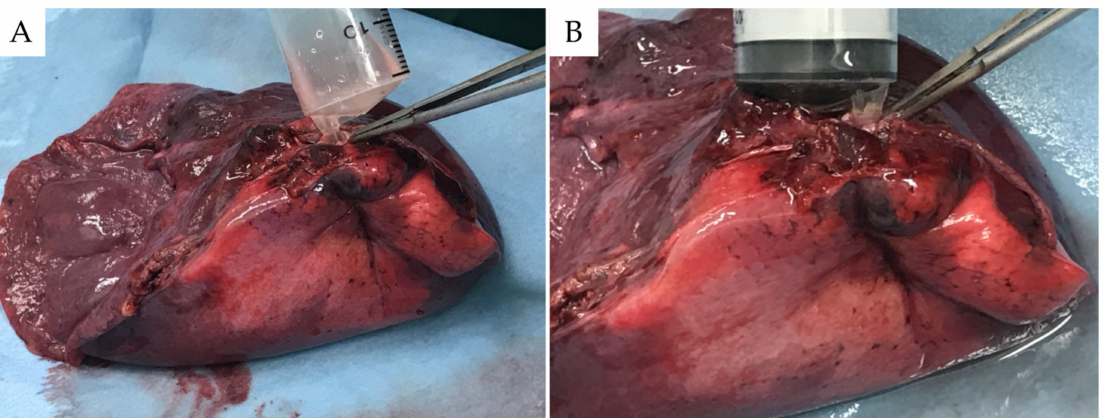
Figure 1. Ex vivo bronchoalveolar lavage (BAL) model. Immediately after lobectomy, a 50 mL syringe was wedged into the bronchus in the segment where a tumor existed, in the lung placed on the back table ( A ). BAL was performed using the same procedure performed in bronchoscopy ( B